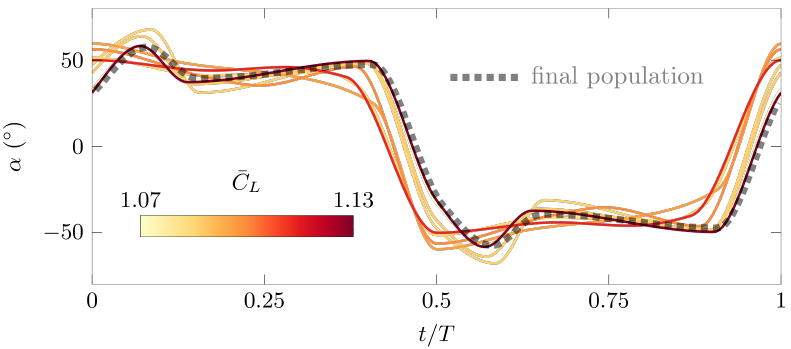
Figure 8. Pitching kinematics of the best individual of the first population for eight repeated runs of the high lift optimization. The line color represents the value of the stroke average lift coefficient. The final solution from the final population is included by the dotted